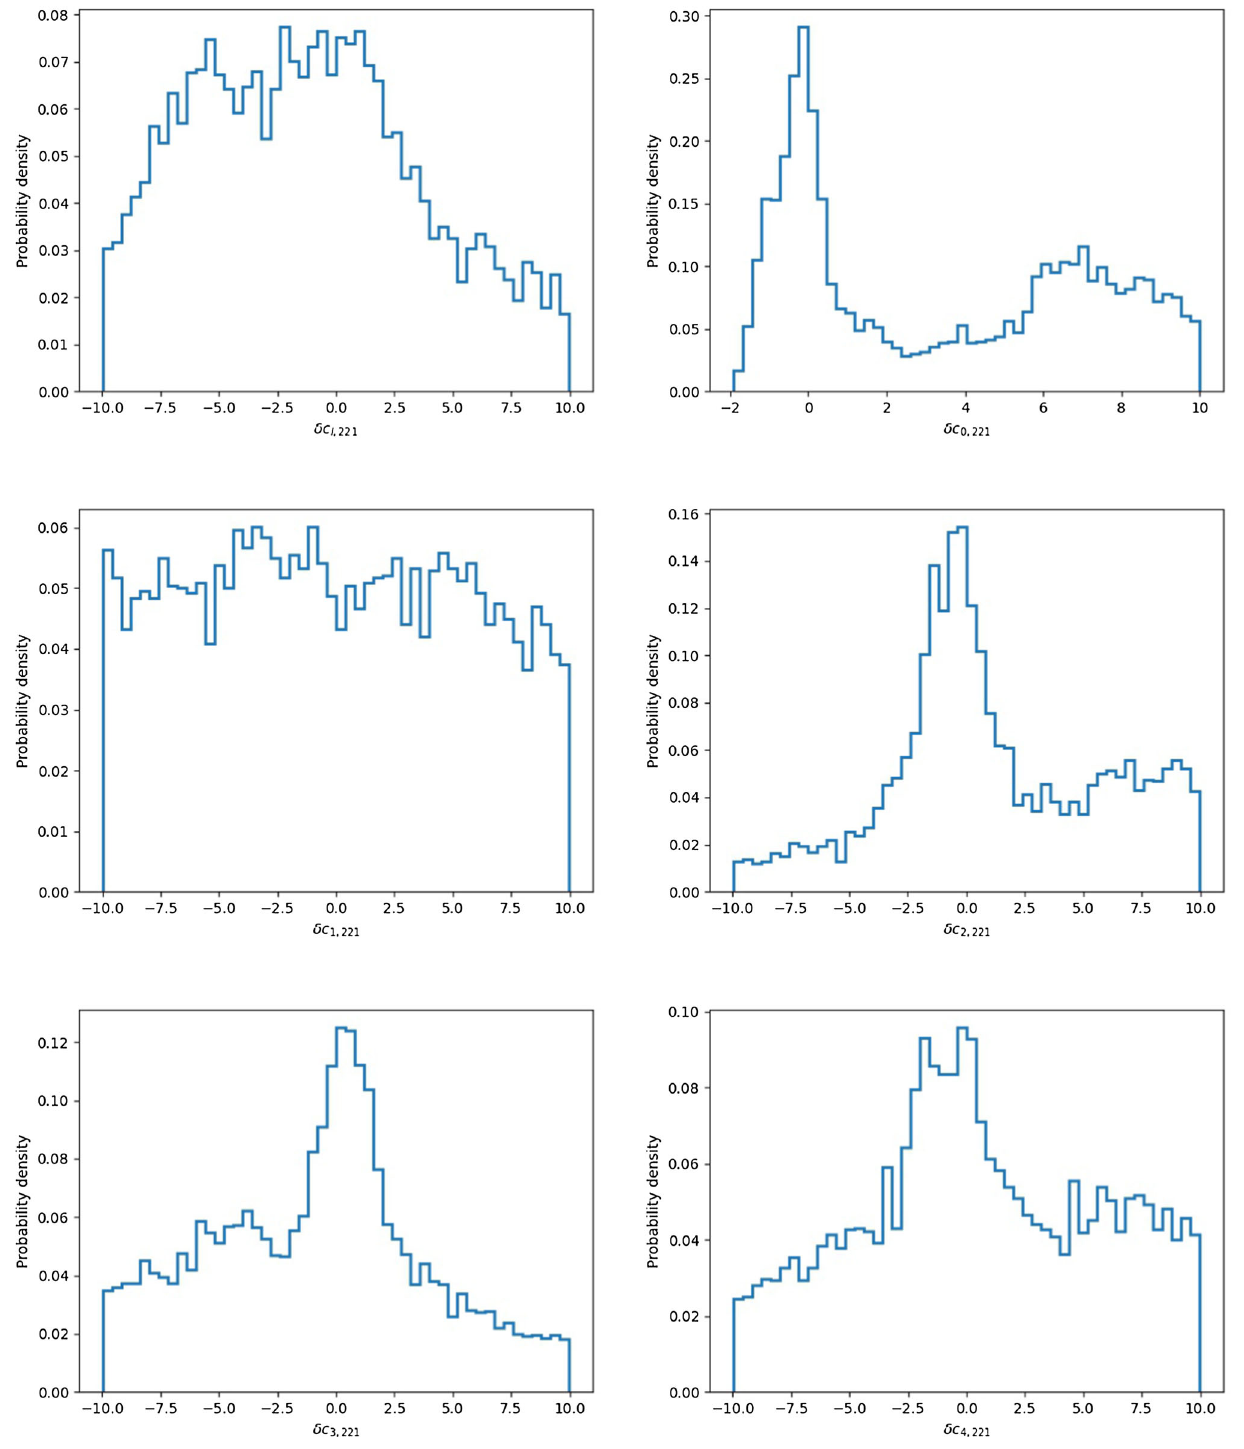
Fig. 1 Posterior distributions for the set of hairs δ c l , i ,